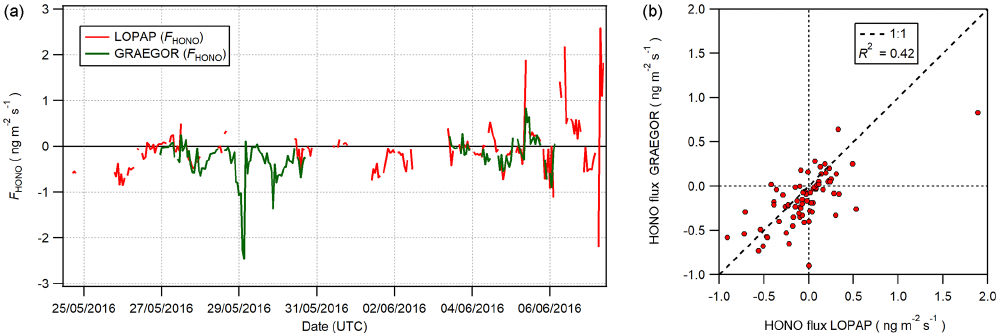
Figure 15. (a) Time series of concurrent flux measurements of HONO derived from LOPAP (red) and GRAEGOR (green) measurements. (b) Scatter plot of GRAEGOR HONO flux values against LOPAP HONO flux